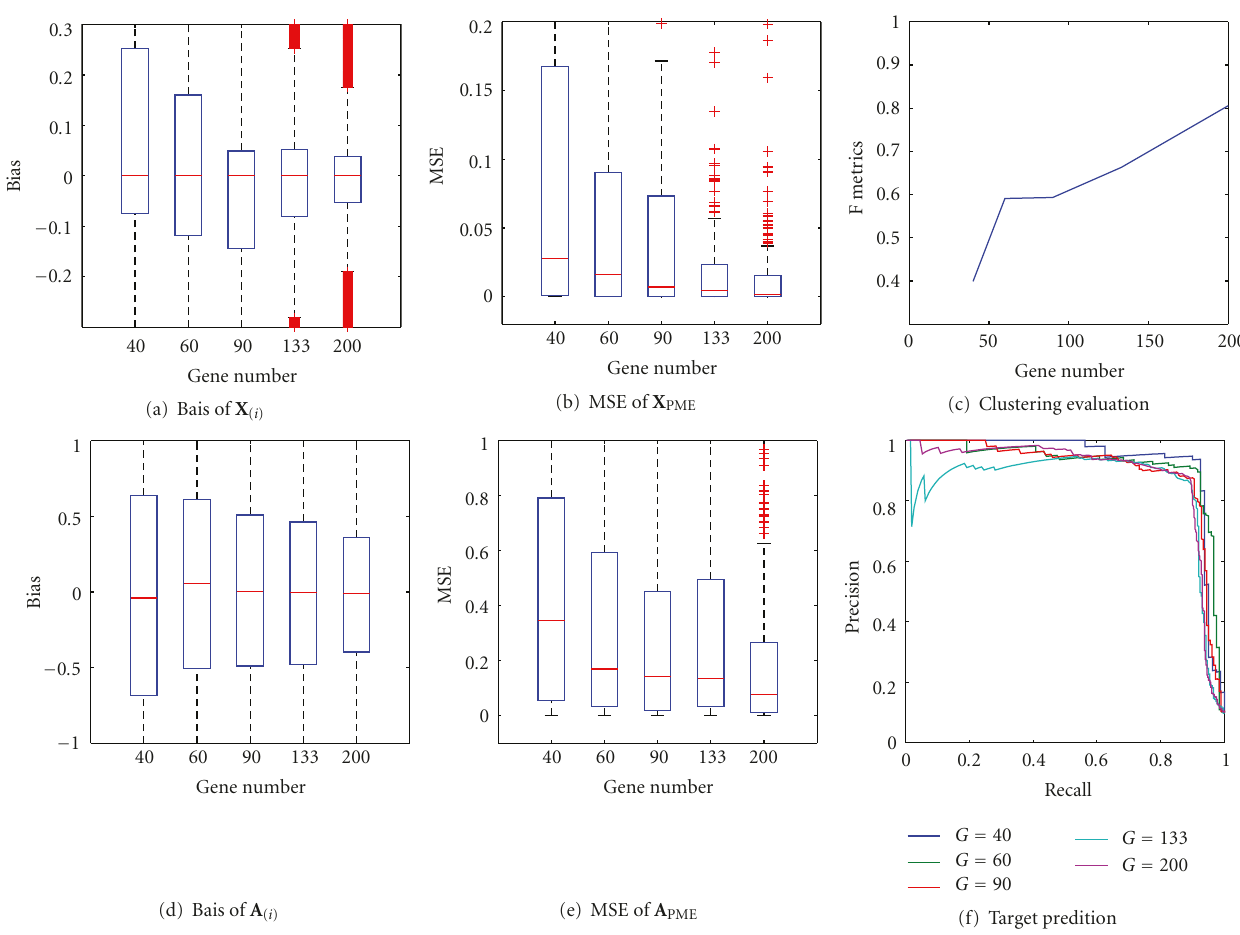
Figure 8: Performance of BSCRFA when the number of genes is di ff erent.